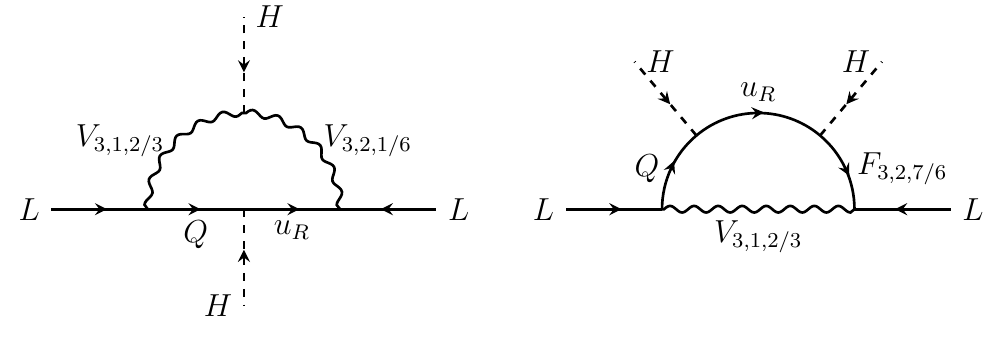
Figure 6 . Two example 1-loop diagrams with vectors instead of scalars. For a discussion see text. multiplet containing this fermion has to be added to complete the particle content of